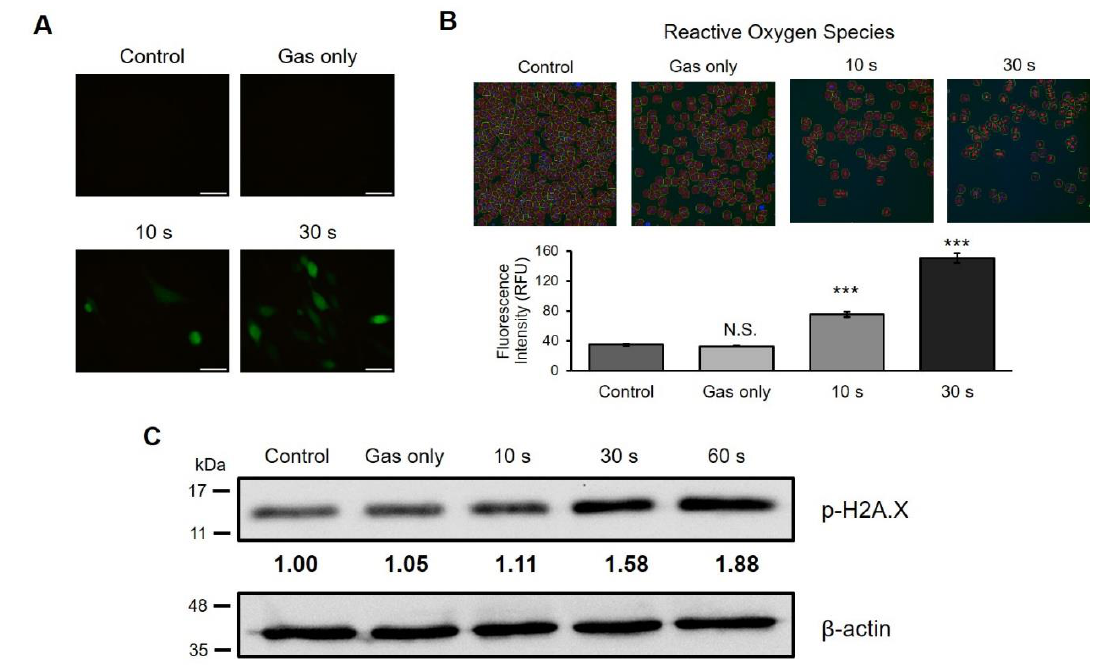
Figure 3. Reactive oxygen species (ROS) generation and DNA damage after exposure to cold atmospheric plasma (CAP). ( A ) Representative images of the canine osteosarcoma D-17 cell line after exposure to CAP at the indicated time. CAP-treated cells were stained with H 2 DCFDA and photographed under a fluorescence microscope. H 2 DCFDA is converted to DCF by ROS. DCF, 2′,7′-dichlorodihydrofluorescein. Scale bars, 50 μm. ( B ) Quantitative analysis of ROS using high-content screening. CAP-treated D-17 cells stained with H 2 DCFDA and Hoechst 33342 were measured by high- content screening technology. Error bars represent the mean ± S.E.M. of three replicates. Magnification, 100X. ( C ) Western blot analysis of DNA damage. Expression of phospho-histone-H2A.X was measured to assess DNA damage. This result represents two independent experiments. The intensity was normalized to β -actin. *** p < 0.001; N.S. indicates not